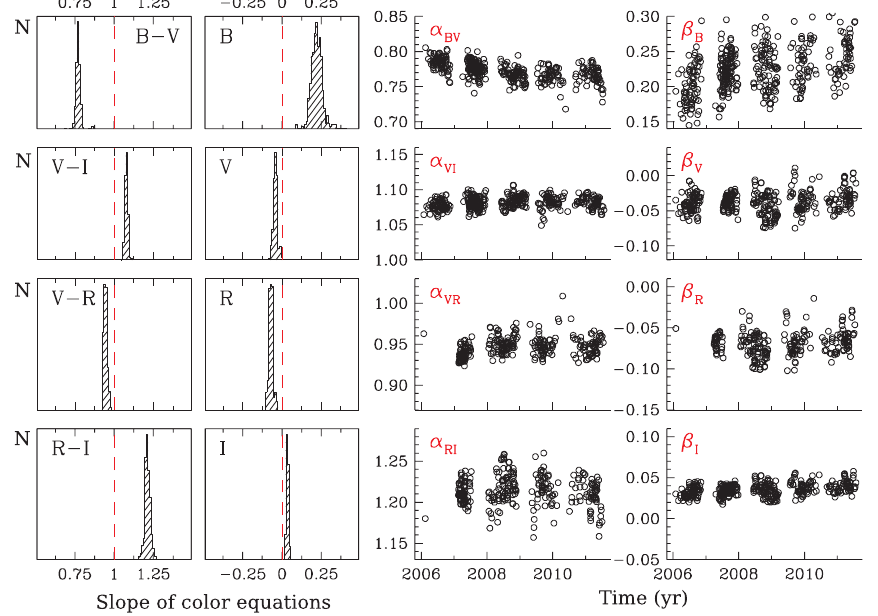
Fig. 4. The left panels exhibit the distribution in colors and magnitudes of 452 obser- vations of the symbiotic star V471 Per collected during 5 years with the telescope R030. The right panels exhibit the coefficients of color equations where some effects of ageing of the filters are